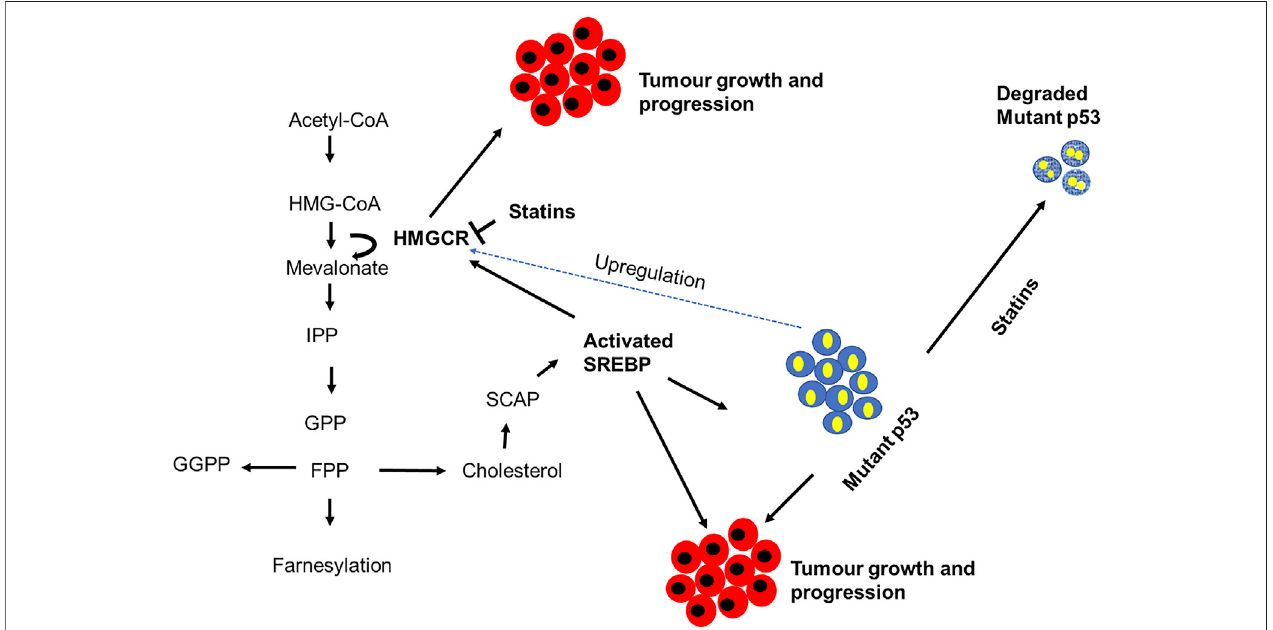
FIGURE 3 | The link between p53 and the mevalonate pathway in cancer cells. This fi gure illustrates how the mevalonate pathway contributes to tumorigenesis using various enzymes or end products. Mutant-p53 upregulates this pathway by activating sterol regulatory element-binding protein (SREBP), 3-hydroxy-3-